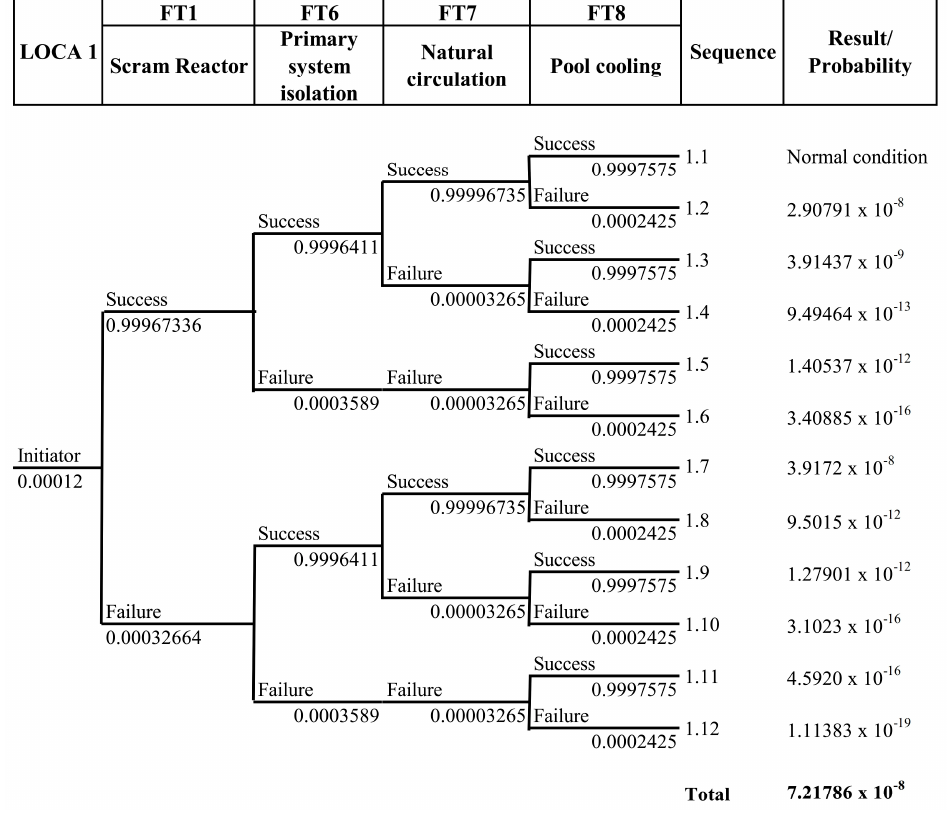
Figure 10. Event tree of LOCA 1.